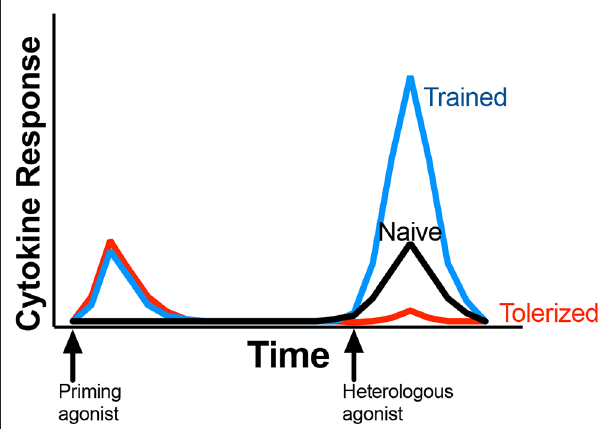
FIGURE 1 | General outline of immune response associated with innate memory. Initial exposure to a priming agonist (red and blue lines) induces an innate response, typically measured as induction of proinflammatory cytokine production. After a rest period, subsequent stimulation of the same cells or animal with a heterologous agonist (commonly LPS or Pam 3 CSK 4 ) results in tolerance or trained response, marked by reduced (red line) or enhanced (blue line) cytokine production when compared to naïve response (black line). Proinflammatory cytokines, including IL-1 β , TNF- α , or IL-6 are the most common cytokines measured for innate memory. Priming and heterologous stimulation may all occur in vitro with primary cells; in vivo ; or a combinantion of in vivo with ex vivo cell